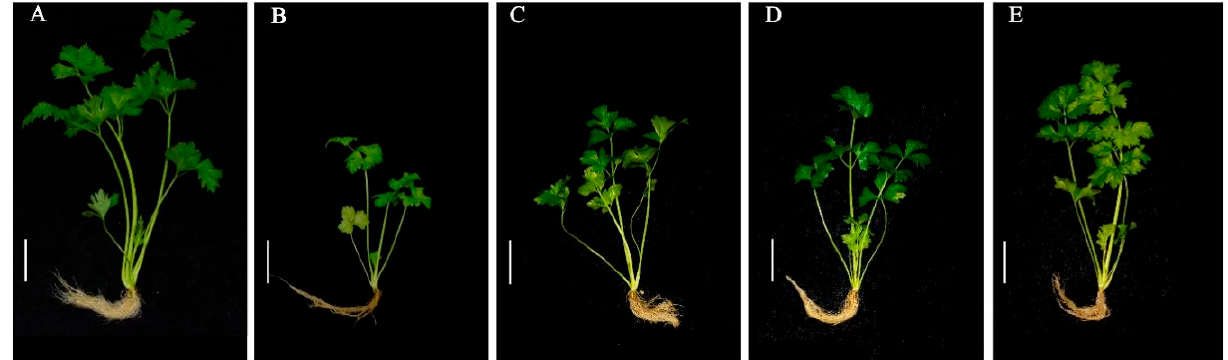
Figure 3. Effects of DCB treatments on celery growth, with celery at 65 DAG. ( A ) Control; ( B ) 2.32 × 10 − 5 mol/L DCB treatment; ( C ) 3.49 × 10 − 5 mol/L DCB 24-EBL treatment; ( D ) 4.65 × 10 − 5 mol/L DCB treatment; ( E ) 5.81 × 10 − 5 mol/L DCB treatment. Scale bars = 5 cm.